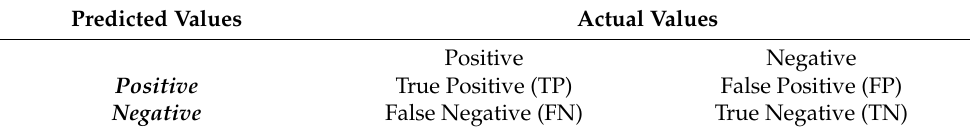
Table 1. Confusion matrix.